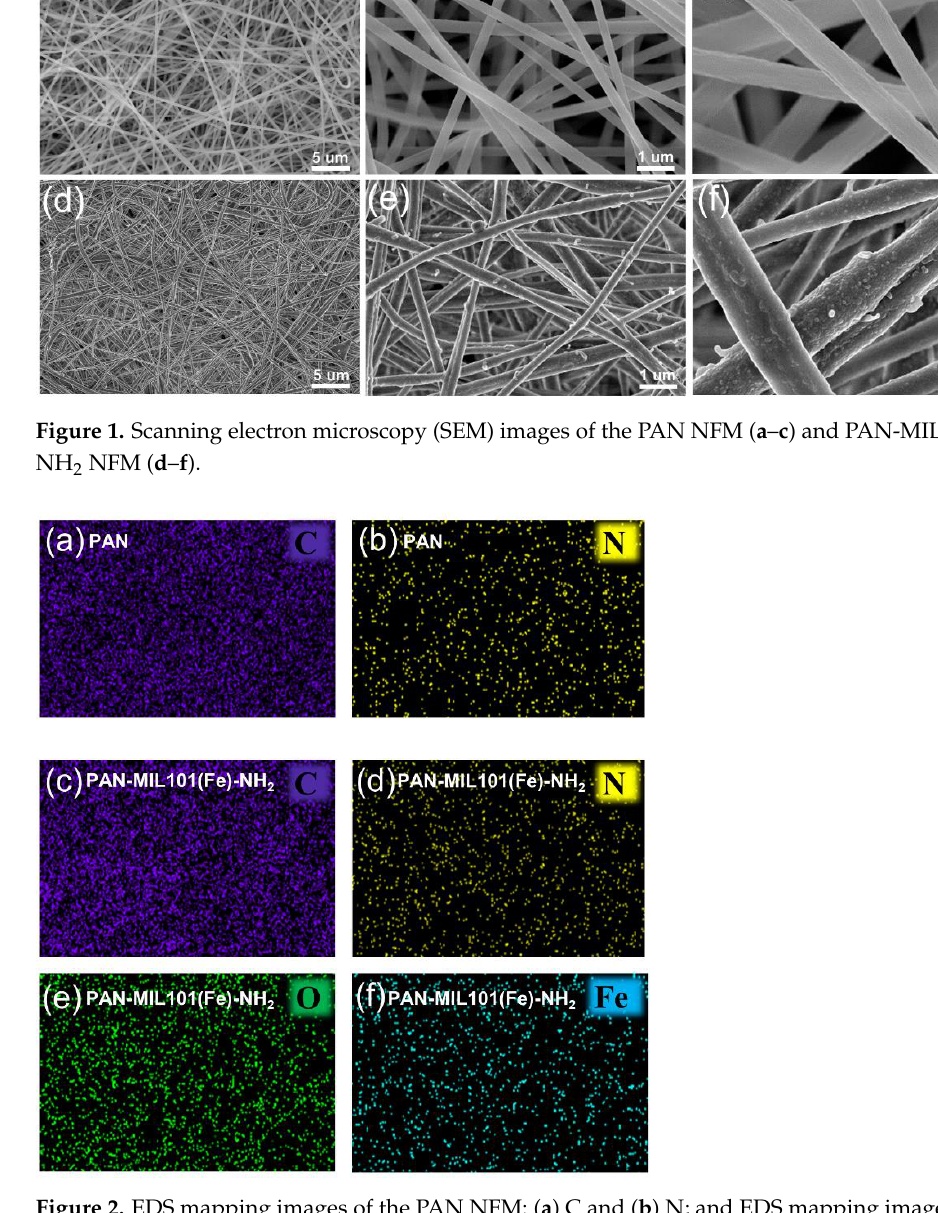
Figure 1. Scanning electron microscopy (SEM) images of the PAN NFM ( a – c ) and PAN-MIL101(Fe)- NH 2 NFM ( d – f ).